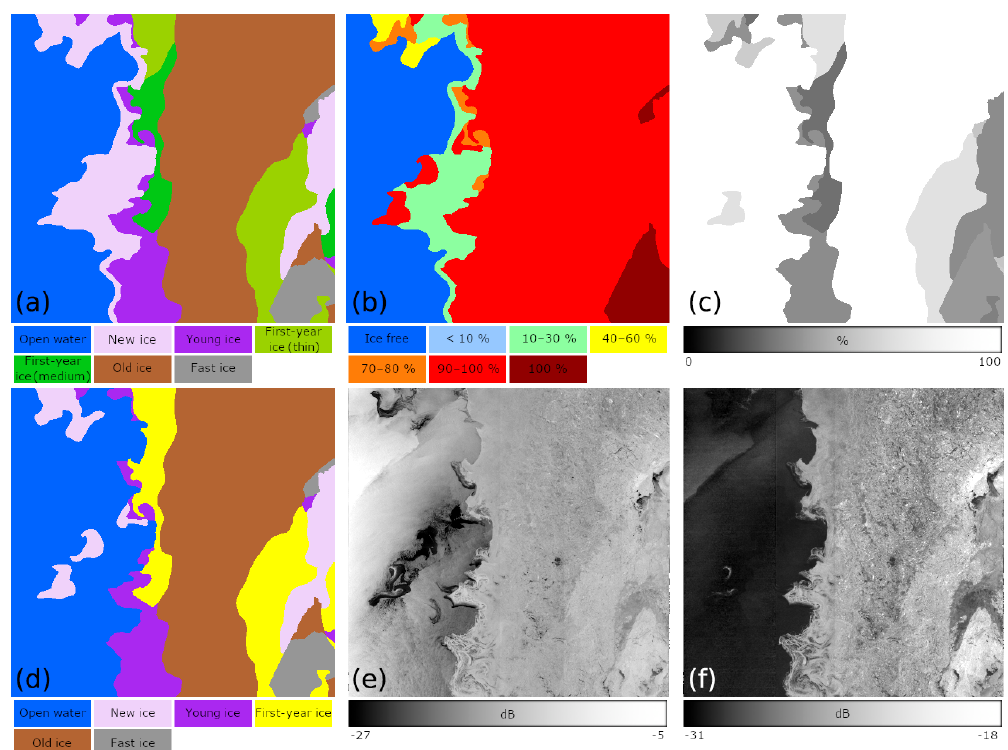
Figure 3. An example of the ice chart preprocessing. From the ice chart, stage of development (SoD; a ), ice concentration (CT; b ), and partial concentration of the dominant ice type (CP; c ) maps are extracted. Then, some of the different SoDs are merged (e.g. thin and thick first-year ice is merged into a single label as first-year ice), and the area with low ice concentration is labelled as open water. The processed map of SoD (d) is related with textural features extracted from HH and HV polarization images (e, f) . Note that the NIC ice chart which was published on 25 January 2018 and the Sentinel-1 product S1B_EW_GRDM_1SDH_20180122T075237_20180122T075337_009281_010A4D_65AA acquired over the Fram Strait were used in this